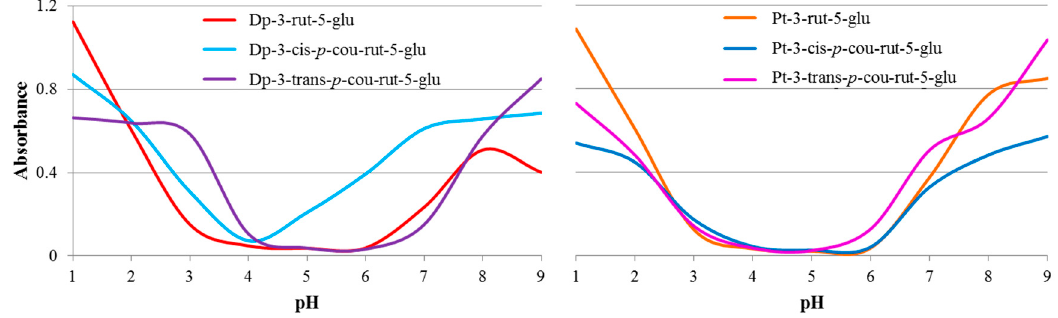
Figure 3. Absorbance of delphinidin (Dp) and petunidin (Pt) derivatives at respective λ max in pH 1–9.